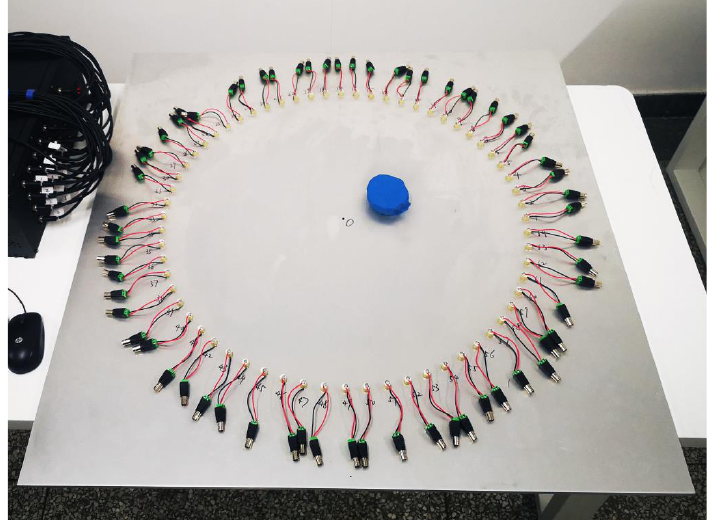
Figure 13. An aluminum plate with a piece of plasticine and 64 piezoelectric sensors.